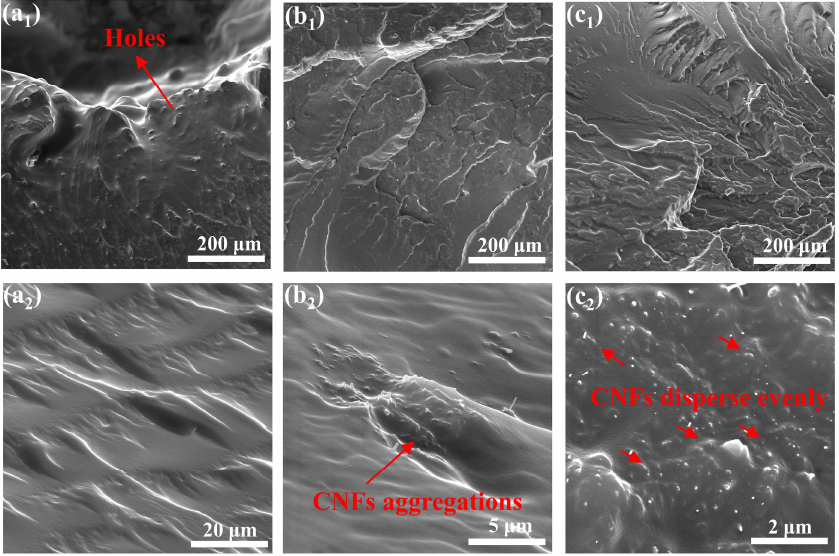
Figure 9. SEM images of the fracture of ( a 1 , a 2 ) PUE, ( b 2 , b 2 ) CNFs/PUE and ( c 1 , c 2 ) PC/PUE–IV after SHPB tests.